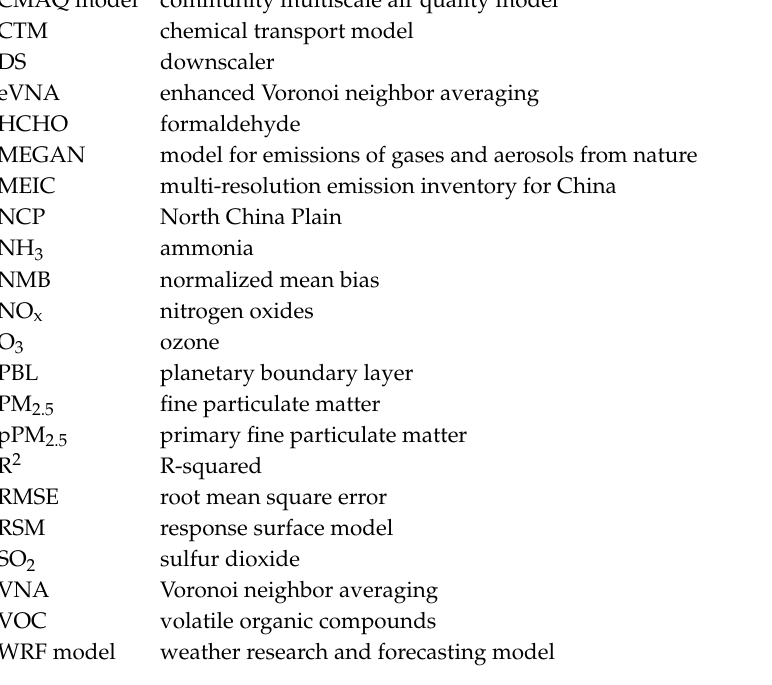
Table S1: number of sites used for nudging in each city, Figure S1: Spatial distribution of five air pollutants emissions of 28 cities in NCP (unit, kt · grid − 1 · yr − 1 ), Figure S2: Comparisons of CMAQ-simulated, observed, and RSM-assimilated PM 2.5 concentrations in Apr 2017, Figure S3: Comparison of observed, CMAQ-simulated, and RSM-assimilated O 3 concentration, Figure S4: Comparison of observed, CMAQ-simulated and RSM-assimilated PM 2.5 concentration, Figure S5: Comparison of observed and simulated PM 2.5 chemical component in a Beijing urban site (relative percentage in total PM 2.5 mass